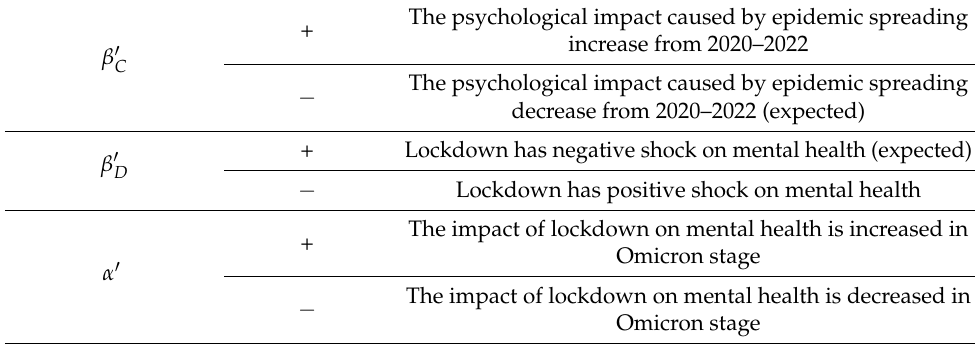
Table 1. Meanings of the sign of DID regression